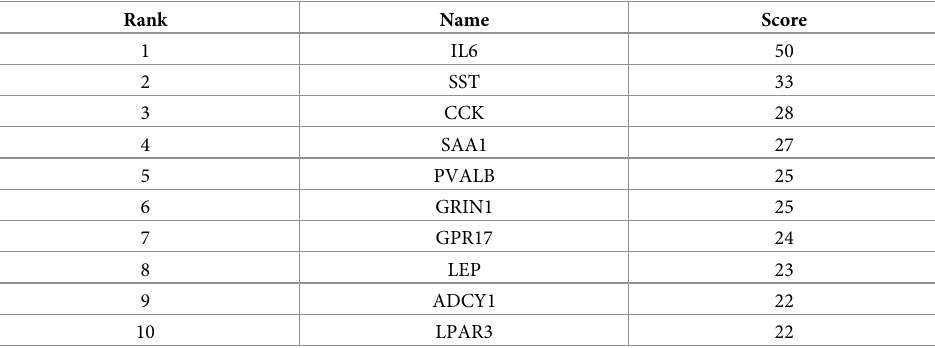
Cytoscape analysis using Cytohubba-plugin reveals IL6 as the highest interconnected gene based on the degree